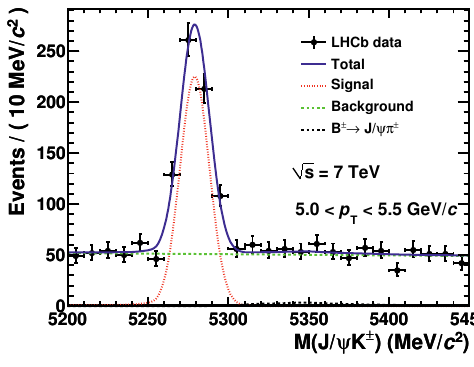
Figure 1. Invariant mass distribution of the reconstructed B + candidates.